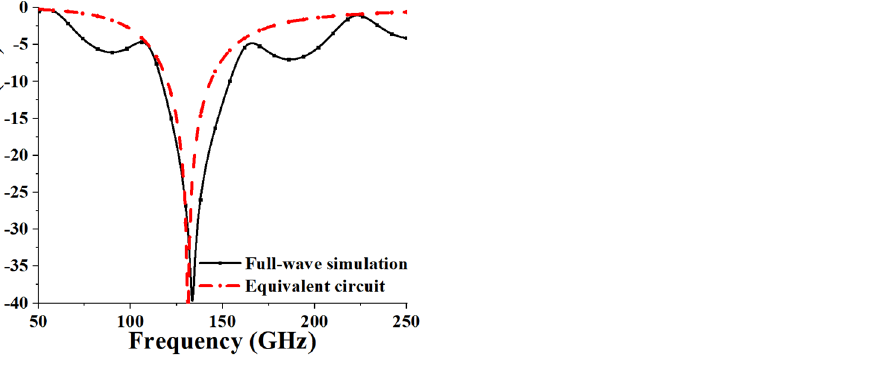
Figure 3. Transmission response under normal incidence: full-wave simulation results (solid line) and equivalent circuit analysis (dashed line).